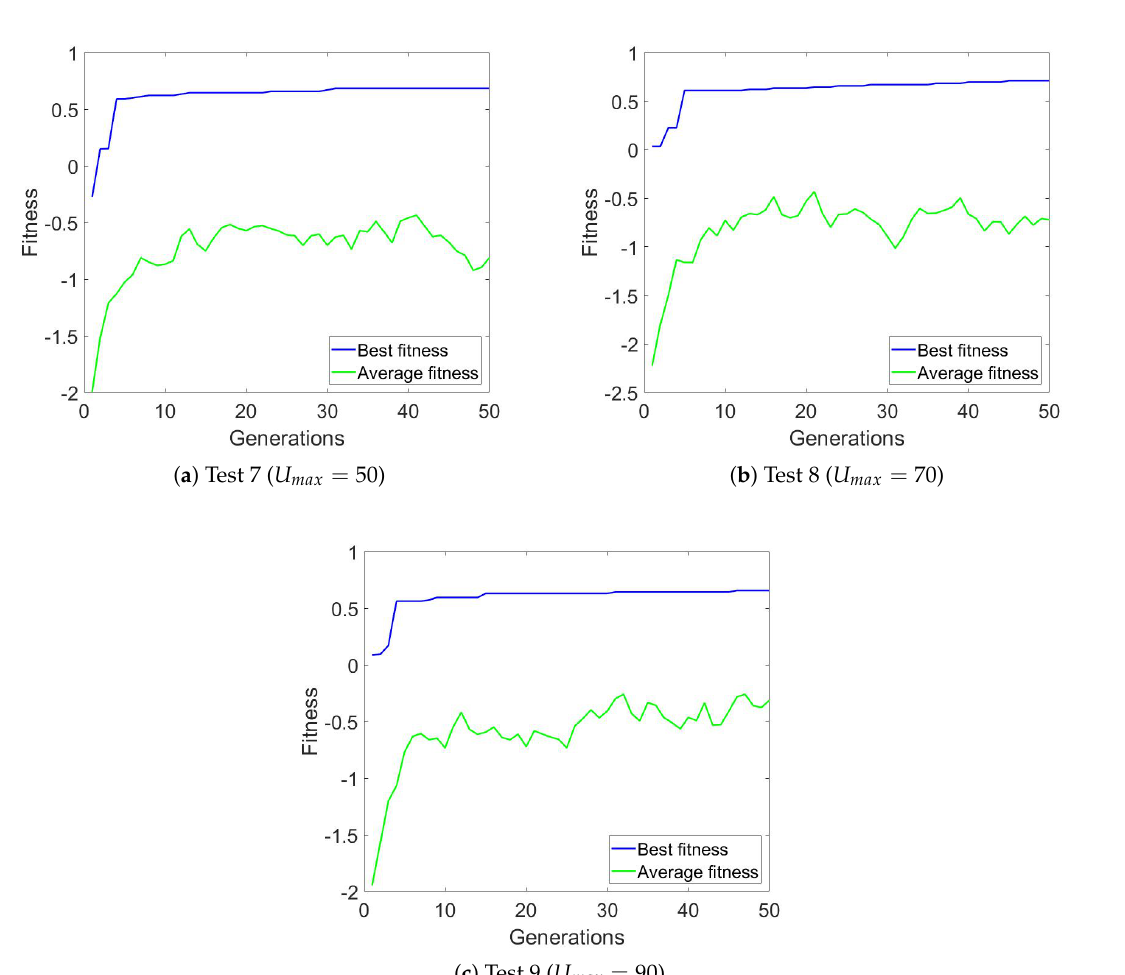
Figure 6. Average and best fitness for Experiment 3 configurations